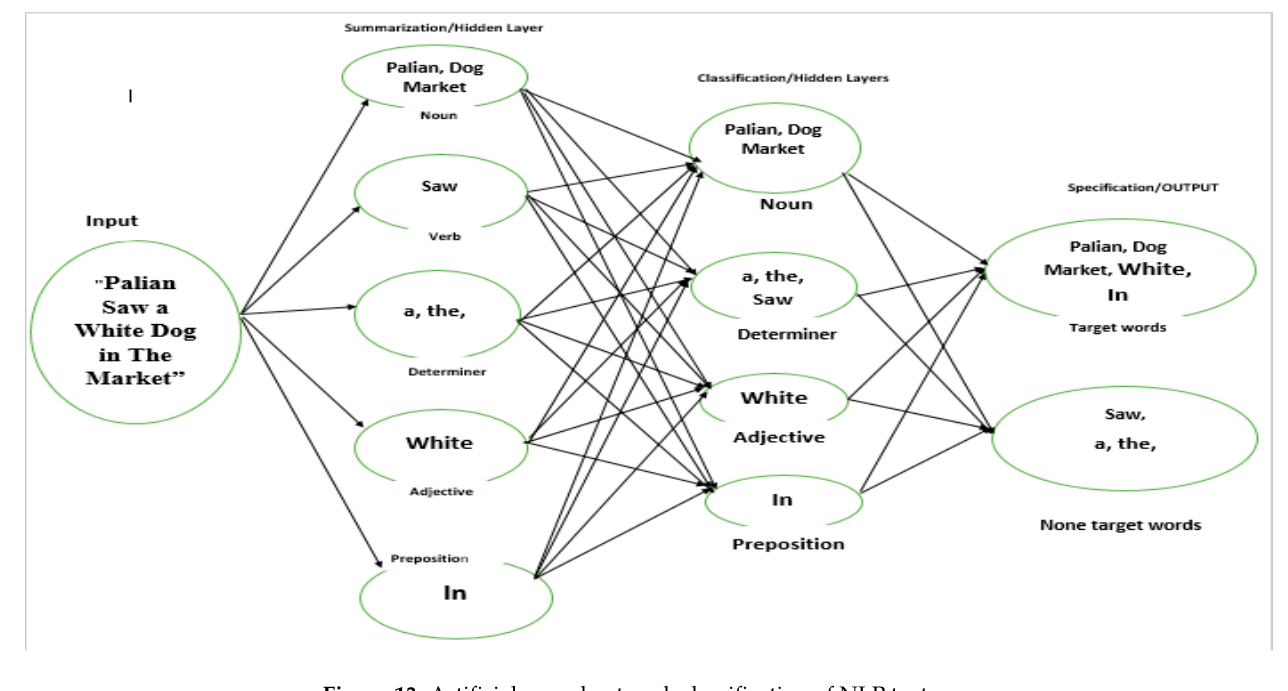
Figure 13. Artificial neural network classification of NLP text.